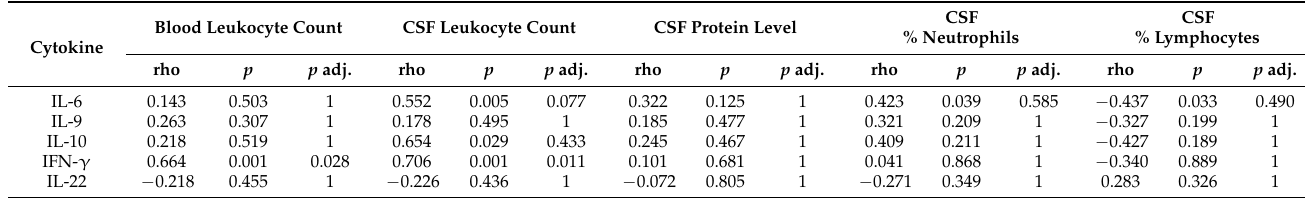
Table 6. Comparison of CSF cytokine levels and CSF/blood laboratory